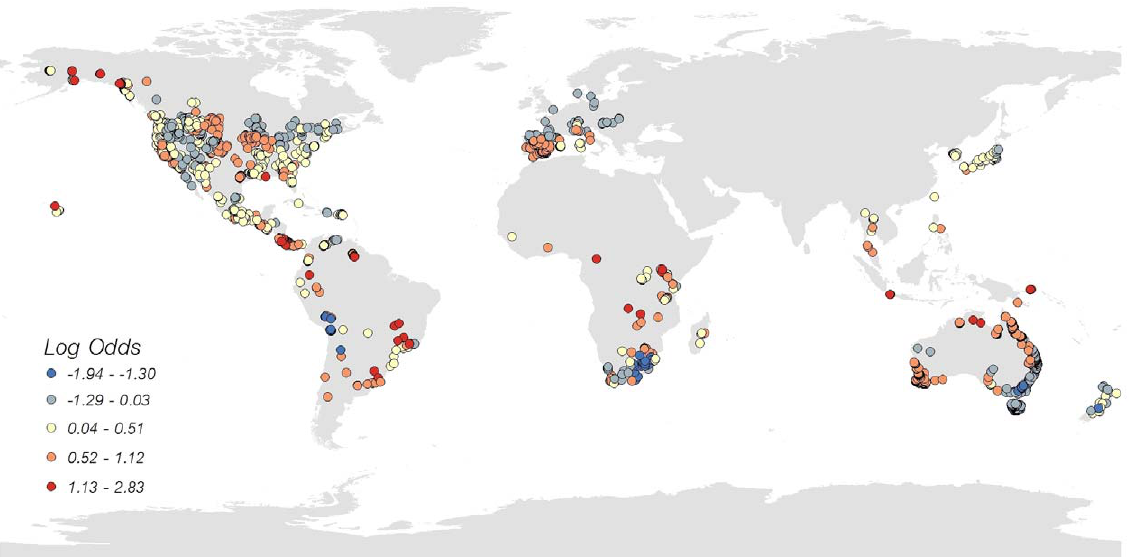
Figure 3. Odds of Batrachochytriumdendrobatidis ( Bd ) detection in amphibians derived from a regression model using data from Bd - maps.net from all species combined (data snapshot July 2010; N=3,733 locations).